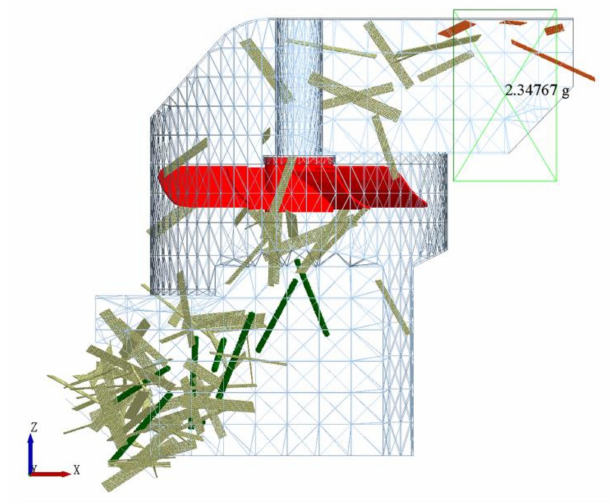
Figure 15. Gas-solid coupling simulation.